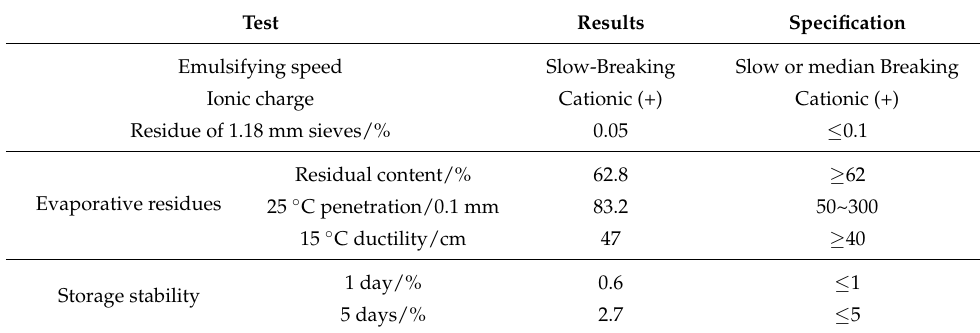
Table 4. Test results of the technical performance of emulsified asphalt.